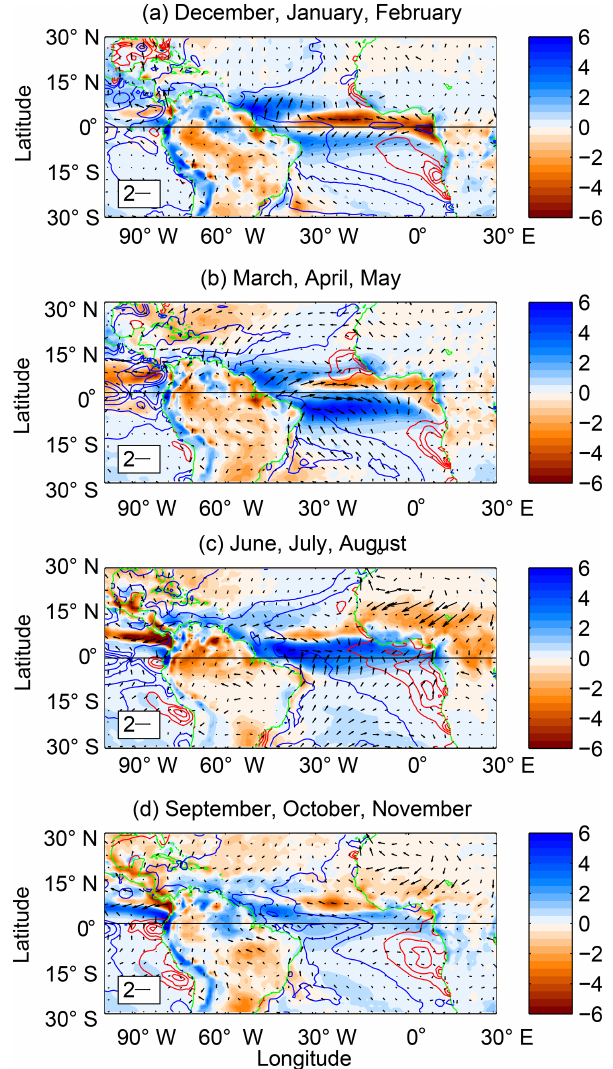
Figure 1. Maps of seasonal mean biases in rainfall (filled con- tours), sea-surface temperature (open contours) and 10m wind vec- tor. Rainfall is in millimetres per day (mmd − 1 ; see colour bar); wind vector is in metres per second (ms − 1 ; see legend for scale) and sea-surface temperature contours are in 0.5 ◦ C increments on each side of zero – red for warm biases, blue for cold biases. Biases are calculated for the seventh month of hindcast and averaged over the seasons and over the years 1998 to 2009 for coupled model S4.